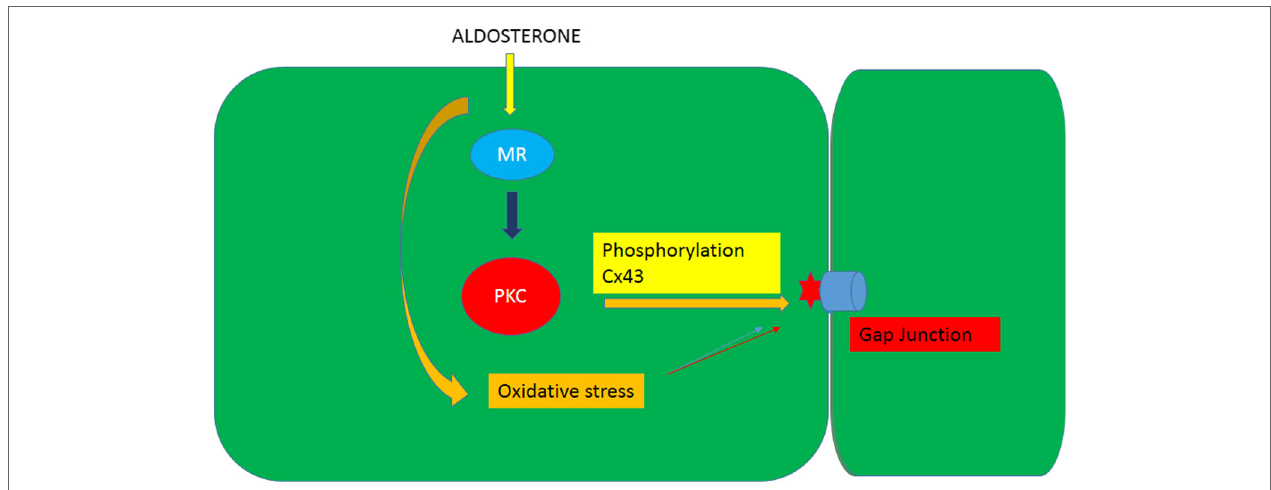
FigUre 8 | Diagram illustrating the influence of aldosterone on the junctional permeability (Pj) to glucose through the generation of oxidative stress an activation of PKc